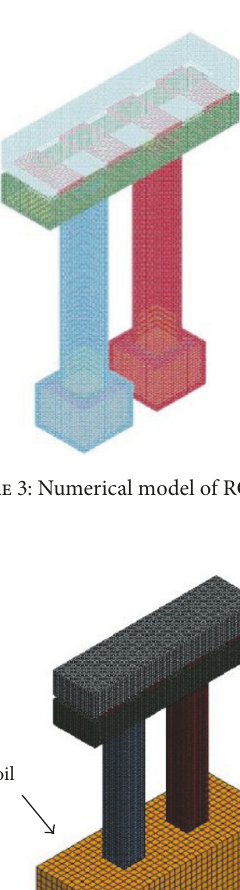
Figure 2: Concrete cracking [2].